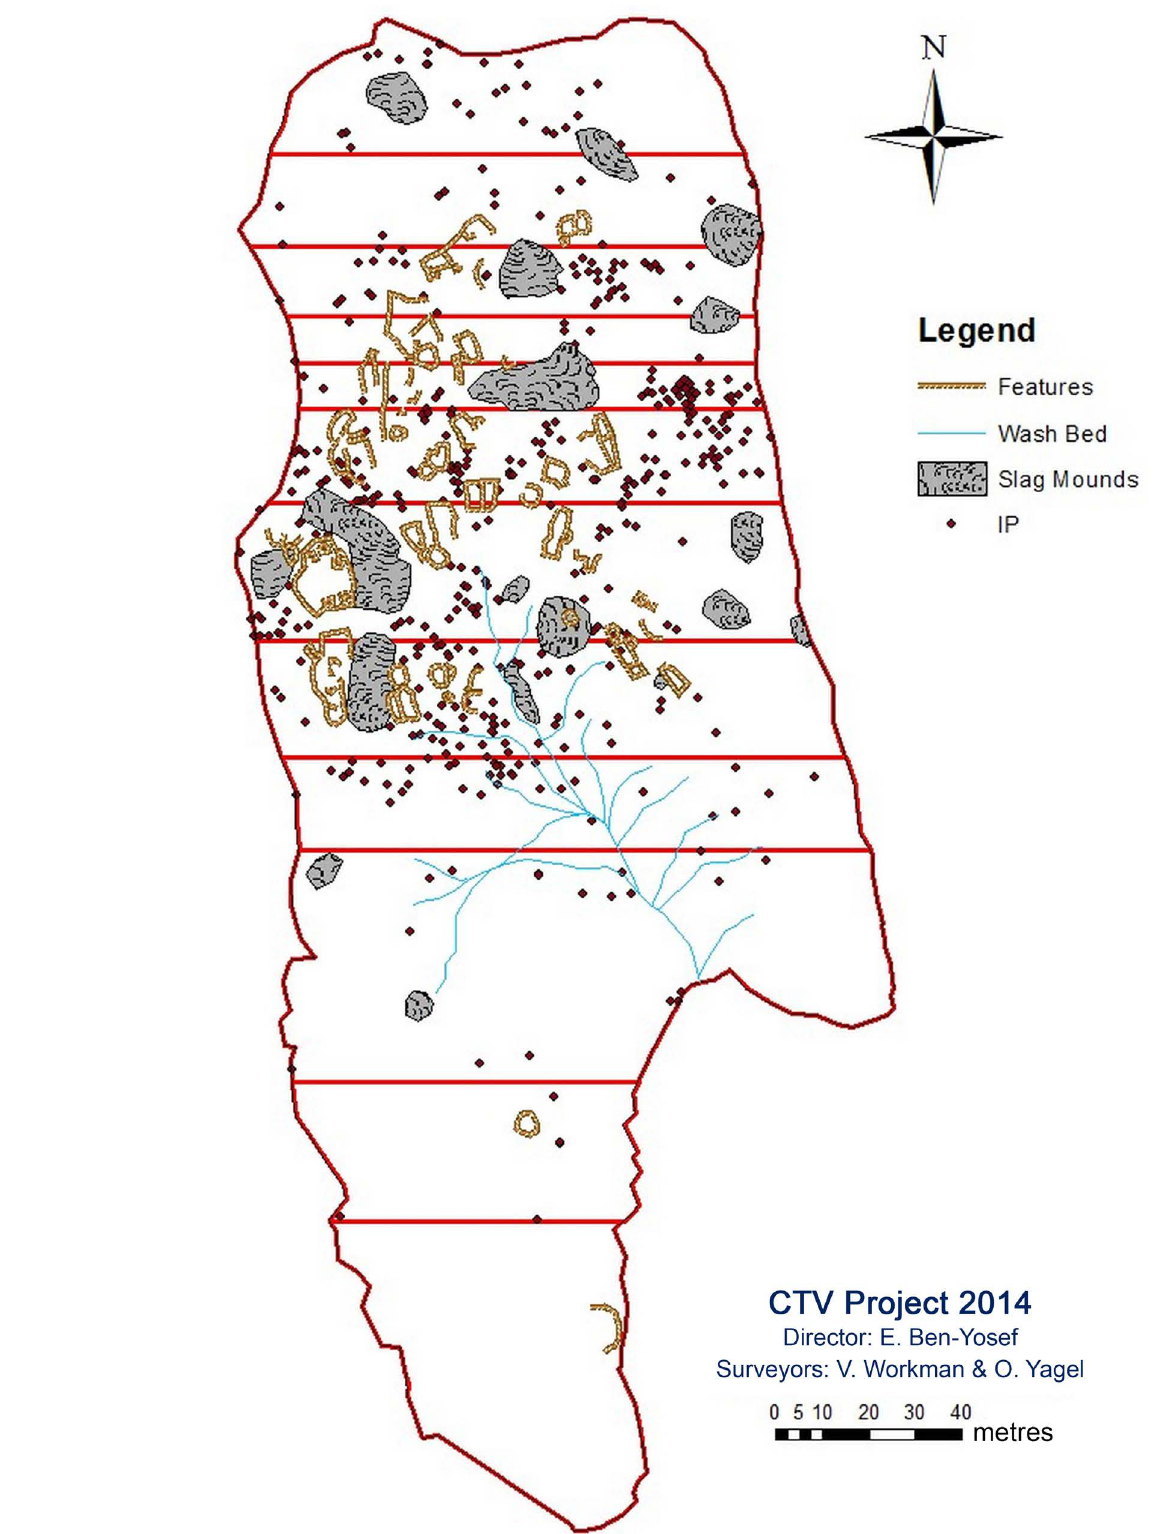
Figure 4. Site 34 survey map including bands and major architectural elements, slag mounds and location of indicative pottery (IP) Sherds (from Ben-Yosef, in press